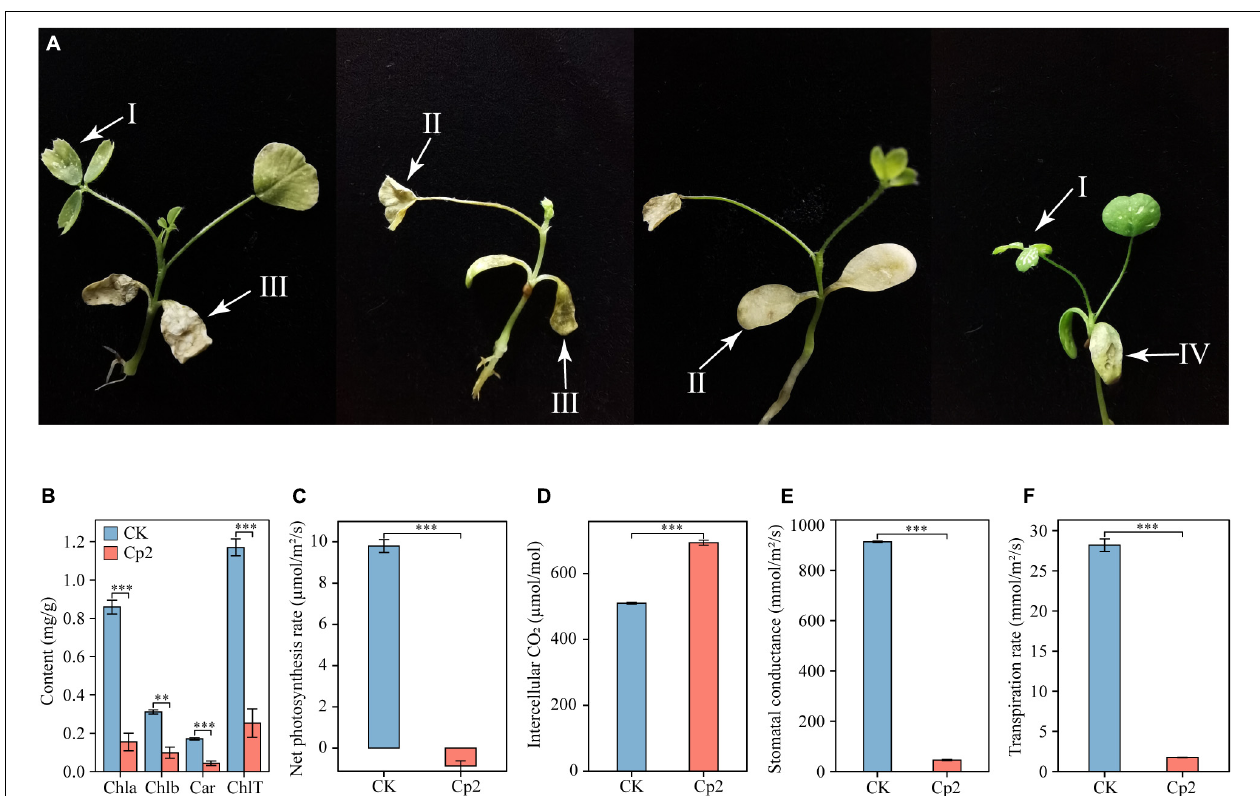
FIGURE 7 | Symptoms on alfalfa leaves (A) caused by E. persicina Cp2. These pictures were taken 21 days. I, leaf spots; II, chlorosis; III, leaf wilting; IV, necrosis. (B) Differences in the chlorophyll content of alfalfa leaves in the CK and Cp2 groups (One-way ANOVA test, Tukey’s HSD test, n = 6). Chla, chlorophyll a ; Chlb, chlorophyll b ; Car, carotenoid; ChlT, total chlorophyll. (C) Net photosynthesis rate. (D) Intercellular CO 2 concentration. (E) Stomatal conductance. (F) Transpiration rate. Independent samples t -test, ns: P ≥ 0.05, ∗ P < 0.01, ∗∗∗ P < 0.001; n = 6; mean ±